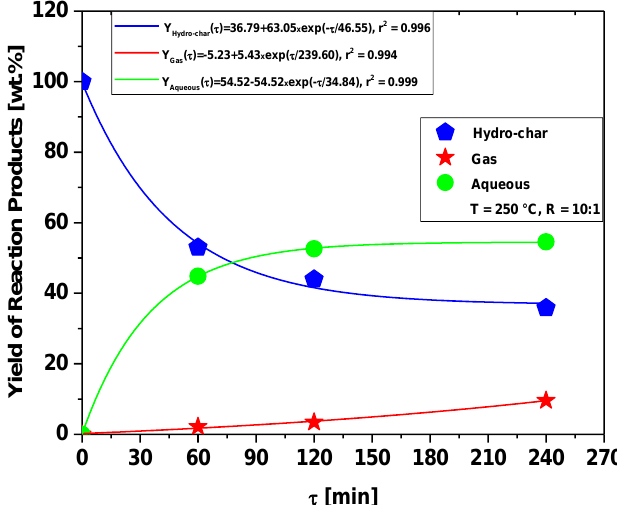
Figure 14. Yield of reaction products (hydro-char, aqueous phase and gas) by the hydrothermal processing of corn stover at 250 °C with a biomass-to-H 2 O ratio of 1:10 after 60, 120 and 240 min using a reactor of 18.75 L. Table 5. Process parameters and material balances by the hydrothermal carbonization of corn stover at 250 ◦ C after 240 min with biomass-to-H 2 O ratios of 1:10, 1:15 and 1:20 using a reactor of 18.75 L.